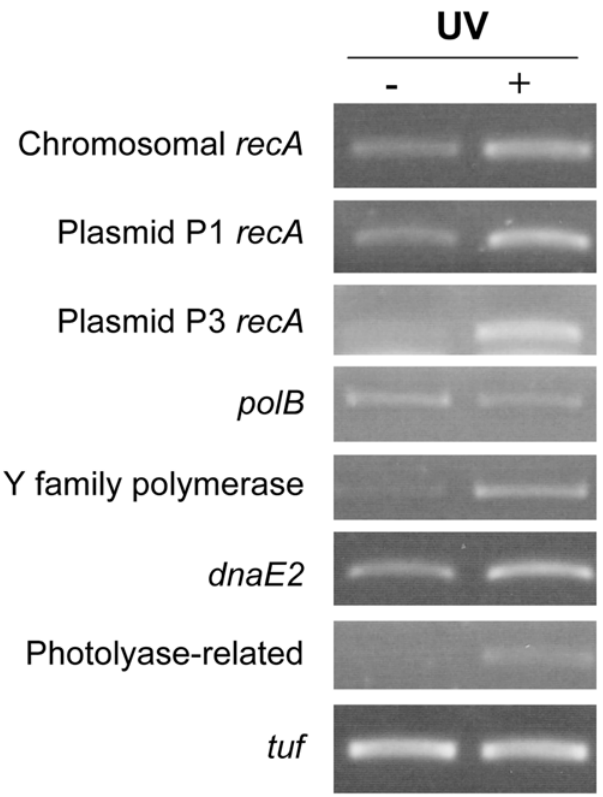
Figure 4. RT-PCR analysis of recA and putative translesion DNA polymerase and photolyase genes. RNA was isolated 30 min after exposure to 0 ( 2 ) or 250 ( + ) J.m 2 2 UV. The constitutively expressed tuf gene was included as